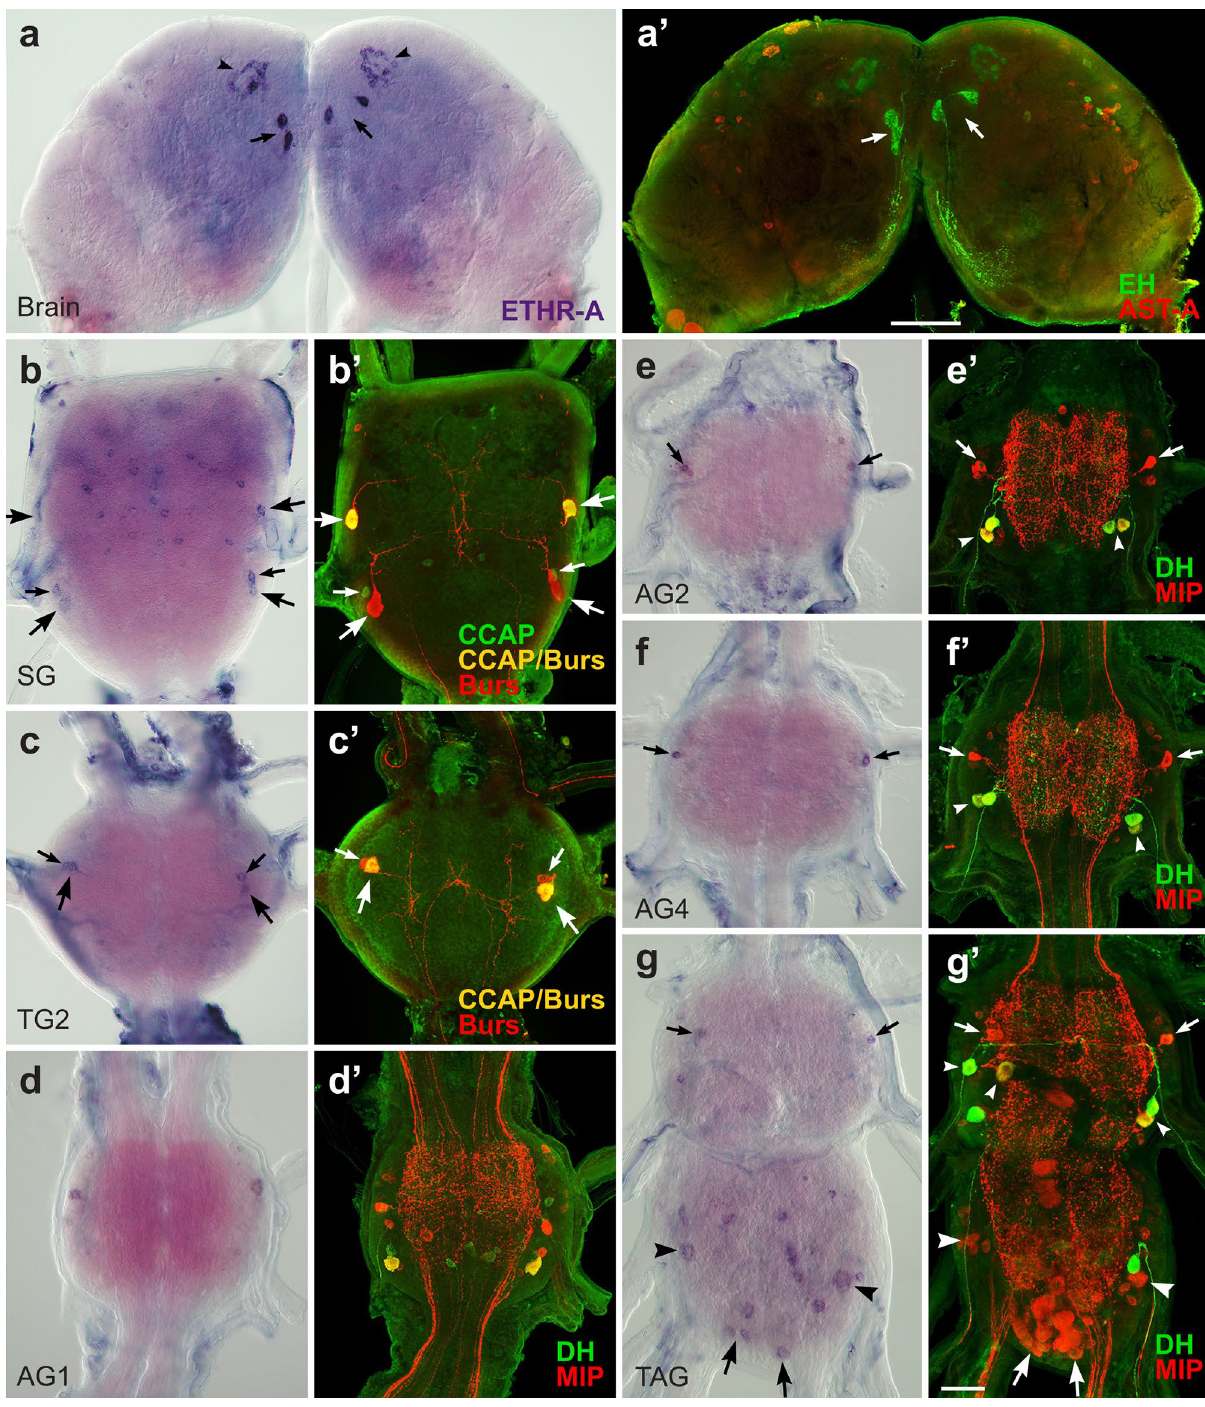
Figure 4. ETHR-A expression in the CNS of pharate pupae. ( a–g’ ) Neurons detected by ISH with ETHR-A probe were identified by subsequent staining with various antibodies. ( a , a ′ ) ETHR-A transcript detected in EH-producing VM neurons (arrows; green) and in two clusters of 20–30 small neurons in the brain (arrowheads). ( b , b ′ ) ETHR-A expression in two pairs of NS-27 producing bursicon and CCAP (arrows; yellow) or bursicon only (arrows; red), posterior IN-704 containing CCAP (small arrows; green) and in ∼ 20 unidentified neurons of the SG. ( c , c’ ) Colocalization of ETHR-A with bursicon and CCAP in NS-27 (large arrows; yellow) and bursicon only in IN-704 of the TG2 (small arrows; red). ( d , d’ ) Unidentified pair of ETHR-A neurons in the AG1 failed to react with antibodies to DH (green) and MIP (red). ( e–g´ ) ETHR-A expression in IN-704 stained with antibody to MIPs (arrows; red) in the AG2-7. Note the absence of ETHR-A in cells L 2,3 producing kinins, DHs and MIPs (small arrowheads; green/yellow). ( g , g’ ) Colocalization of ETHR-A and MIP in VL8 cells (arrowheads; red) and PM9 (large arrows; red) in the posterior TAG. ETHR-A was detected in additional 4–5 pairs of unidentified neurons. Scale bars a, a´ = 100 µm, b–g´ = 50